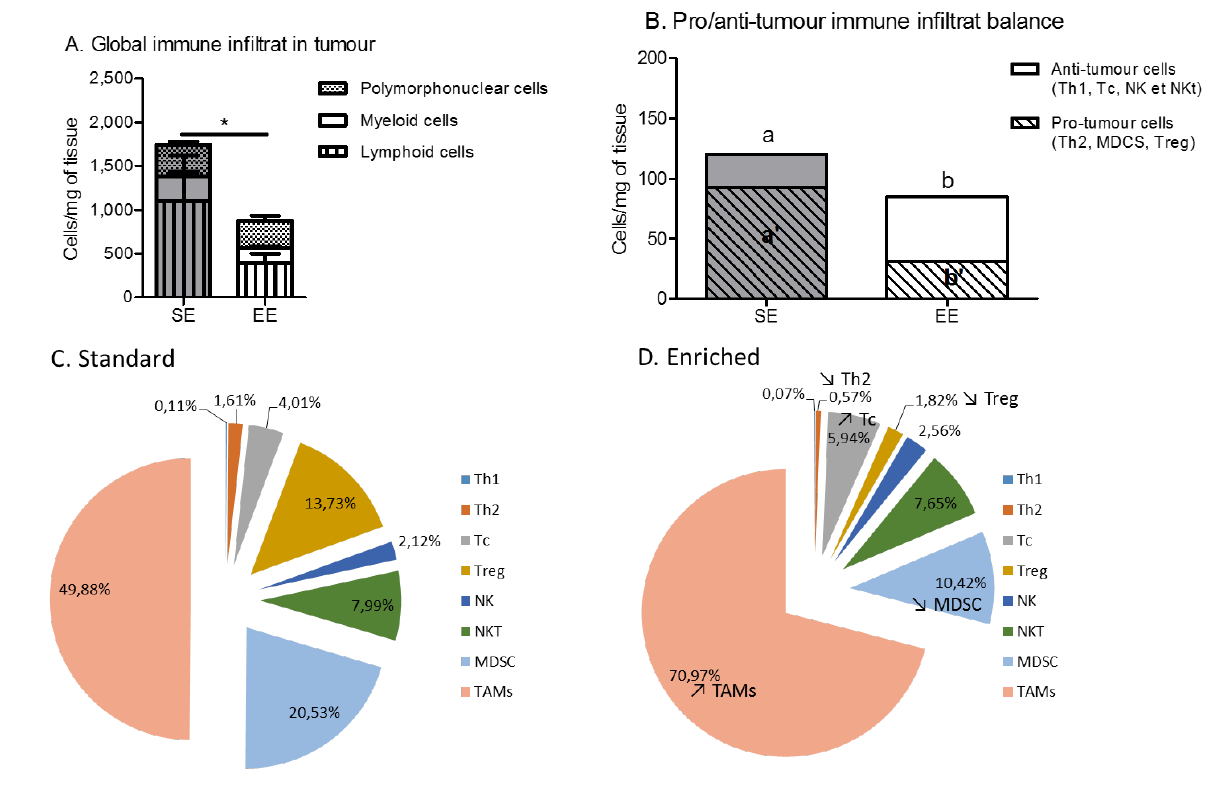
Figure 5. Spontaneous physical activity induces a decrease in the immune infiltrate to the benefit of anti-inflammatory and cytotoxic cells. ( A ) Global immune infiltrate in the tumours, results are in cells per mg of tumour ( B ) Pro-/anti-tumour immune infiltrate balance in tumour with results in cells per mg of tumour. ( C ) Immune phenotyping of the immune infiltrate in tumour of standard group, with results in % of immune live cells. ( D ) Immune phenotyping of the immune infiltrate in tumour of enriched group, with results in % of immune live cells. Data are expressed as mean ± SEM ( n = 5 mice tumour phenotyping analysis/group). Data were analysed by Mann–Whitney t -test. Representative data are shown: * p < 0.05, SE vs. EE. Representative data are shown for a and b, and means without a common letter on a same line are significantly different, SE vs. EE.